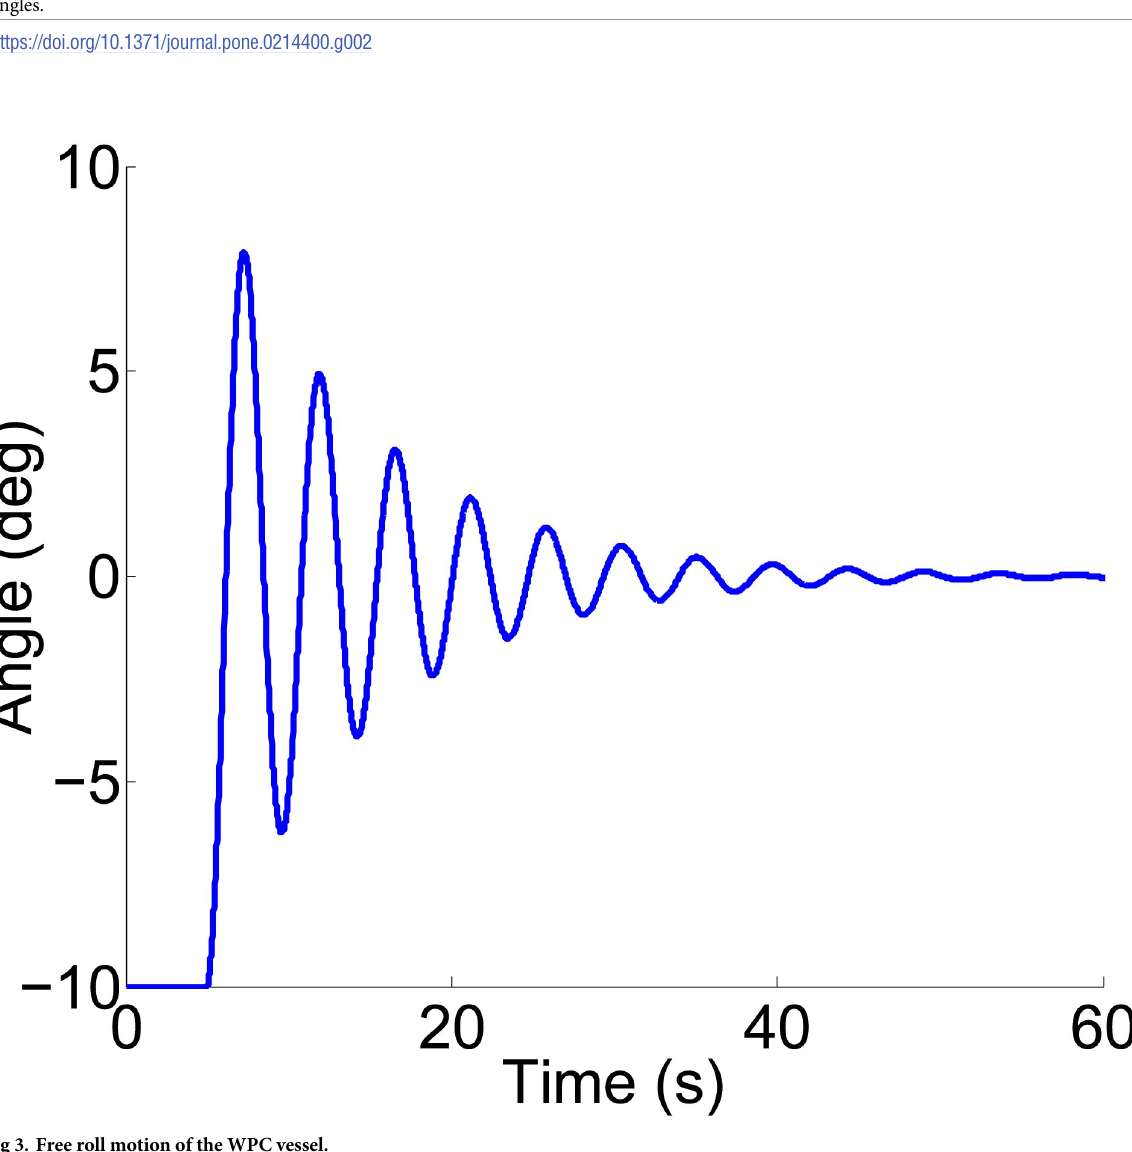
PLOS ONE | https://doi.org/10.1371/journal.pone.0214400 March 25,